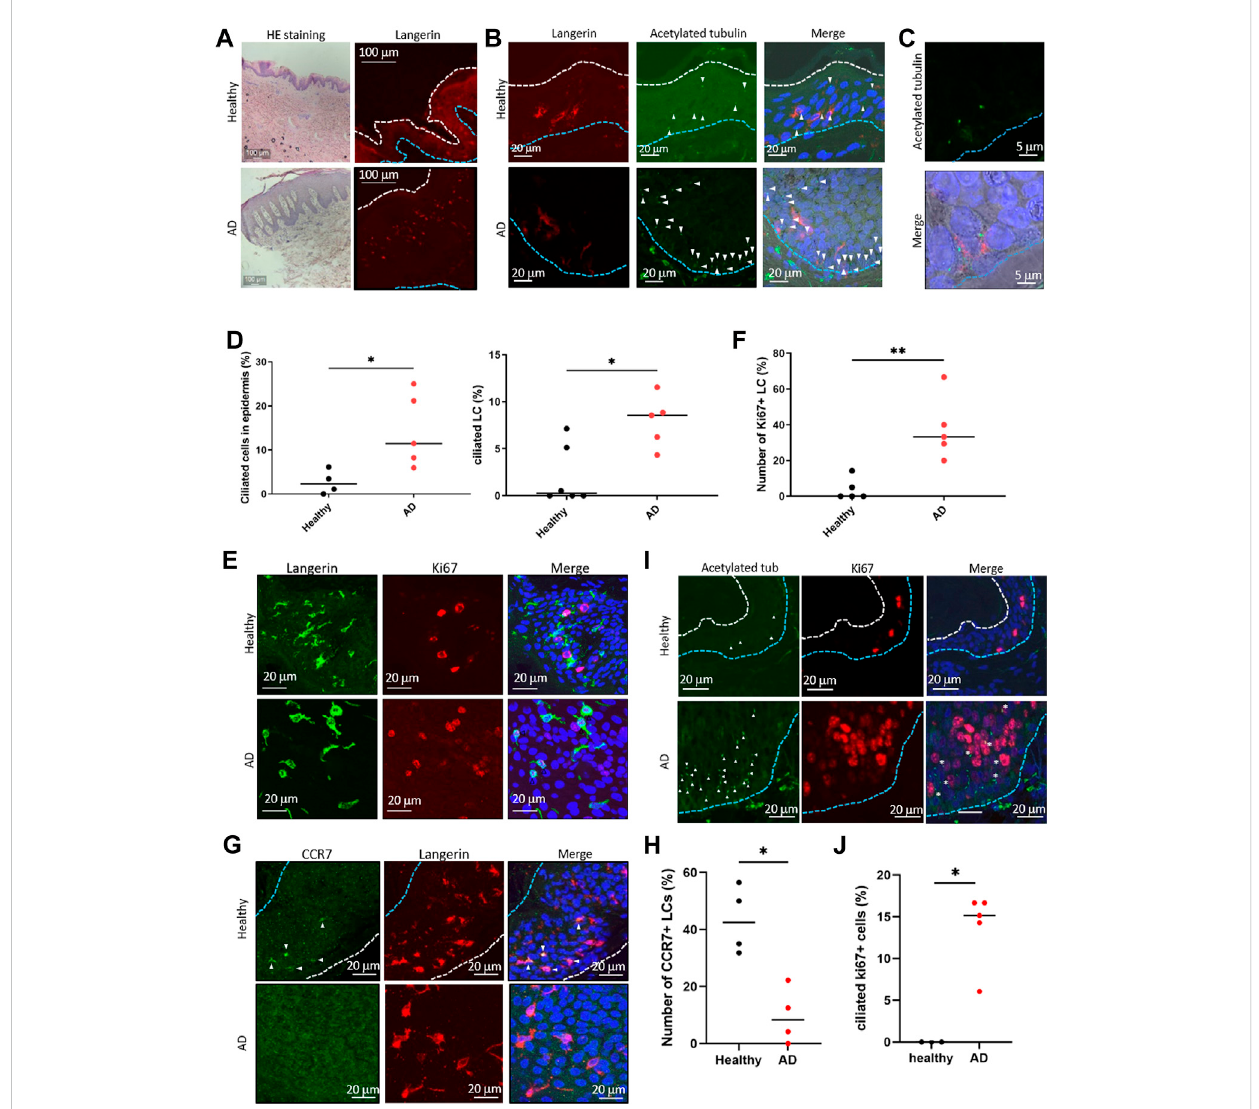
FIGURE 4 Primary cilium and immature LCs are increased in the atopic dermatitis epidermis. (A) (Left) Representative image of HE staining of the human epidermis. (Right) Representative image of langerin in the epidermis. The blue dotted line indicates the basal membrane. The white dotted line indicates thestratumcorneum.Threebiologicalreplicates(3donors)wereexamined.Theupperpanelsshowhealthyskin.Thelowerpanelsshowatopicdermatitis (AD) skin. Scale bar: 100 μ m. (B) Langerin and acetylated tubulin were immunostained in the human epidermis. The blue dotted line indicates the basal membrane. The arrow indicates the primary cilium. Scale bar: 20 μ m. Four biological replicates (4 donors) for healthy samples and 5 biological replicates (5 donors) for AD samples were examined. (C) Magni fi ed image of primary ciliated LCs in the AD patient epidermis. Langerin is shown in red. Acetylated tubulin is shown in green. Scale bar: 5 μ m. (D) (Left) The percentage of primary ciliated epidermal cells, and (right) the percentage of primary ciliated LCs in the healthy or AD epidermis. Healthy samples: n = 4 or n = 6, AD samples: n = 5. The bar indicates the median value. *, p < 0.05 (Mann- Whitney U test). (E) Representative images of langerin and Ki67 in the epidermis. Scale bar: 20 μ m. (F) Quantitation of data shown in Figure 4E. Ki67- positiveLCsinthehealthyandADepidermiswerecountedandgraphed.Healthysamples:n=5,ADsamples:n=5.**, p < 0.01(Mann-Whitney U test). (G) Immunostaining of CCR7 (green) and langerin (red) in the human epidermis. The blue dotted line indicates the basal membrane. The white dotted line indicates the stratum corneum. The arrow indicates CCR7-positive LC. Four biological replicates (4 donors) were examined. Scale bar: 20 μ m. (H) Quantitation of the data shown in panel (G) . CCR7-positive LCs in the healthy and AD epidermis were counted and graphed. Healthy individual samples: n = 4, AD skin samples: n = 4. *, p < 0.05 (Mann-Whitney U test). (I) Immunostaining of acetylated tubulin (green) and Ki67 (red) in epidermis derived from healthy donors or AD patients. The blue dotted line indicates the basal membrane. The white dotted line indicates the stratum corneum. The arrow indicates the primary cilium. The asterisk shows Ki67-positive primary ciliated cells. Scale bar: 20 μ m. (J) Quantitation of the data shown in panel (I) . Acetylated tubulin-positive, Ki67-positive cells in the healthy and AD epidermis were counted and graphed. Healthy individual samples: n = 3, AD skin samples: n = 5. *, p < 0.05 (Mann-Whitney U